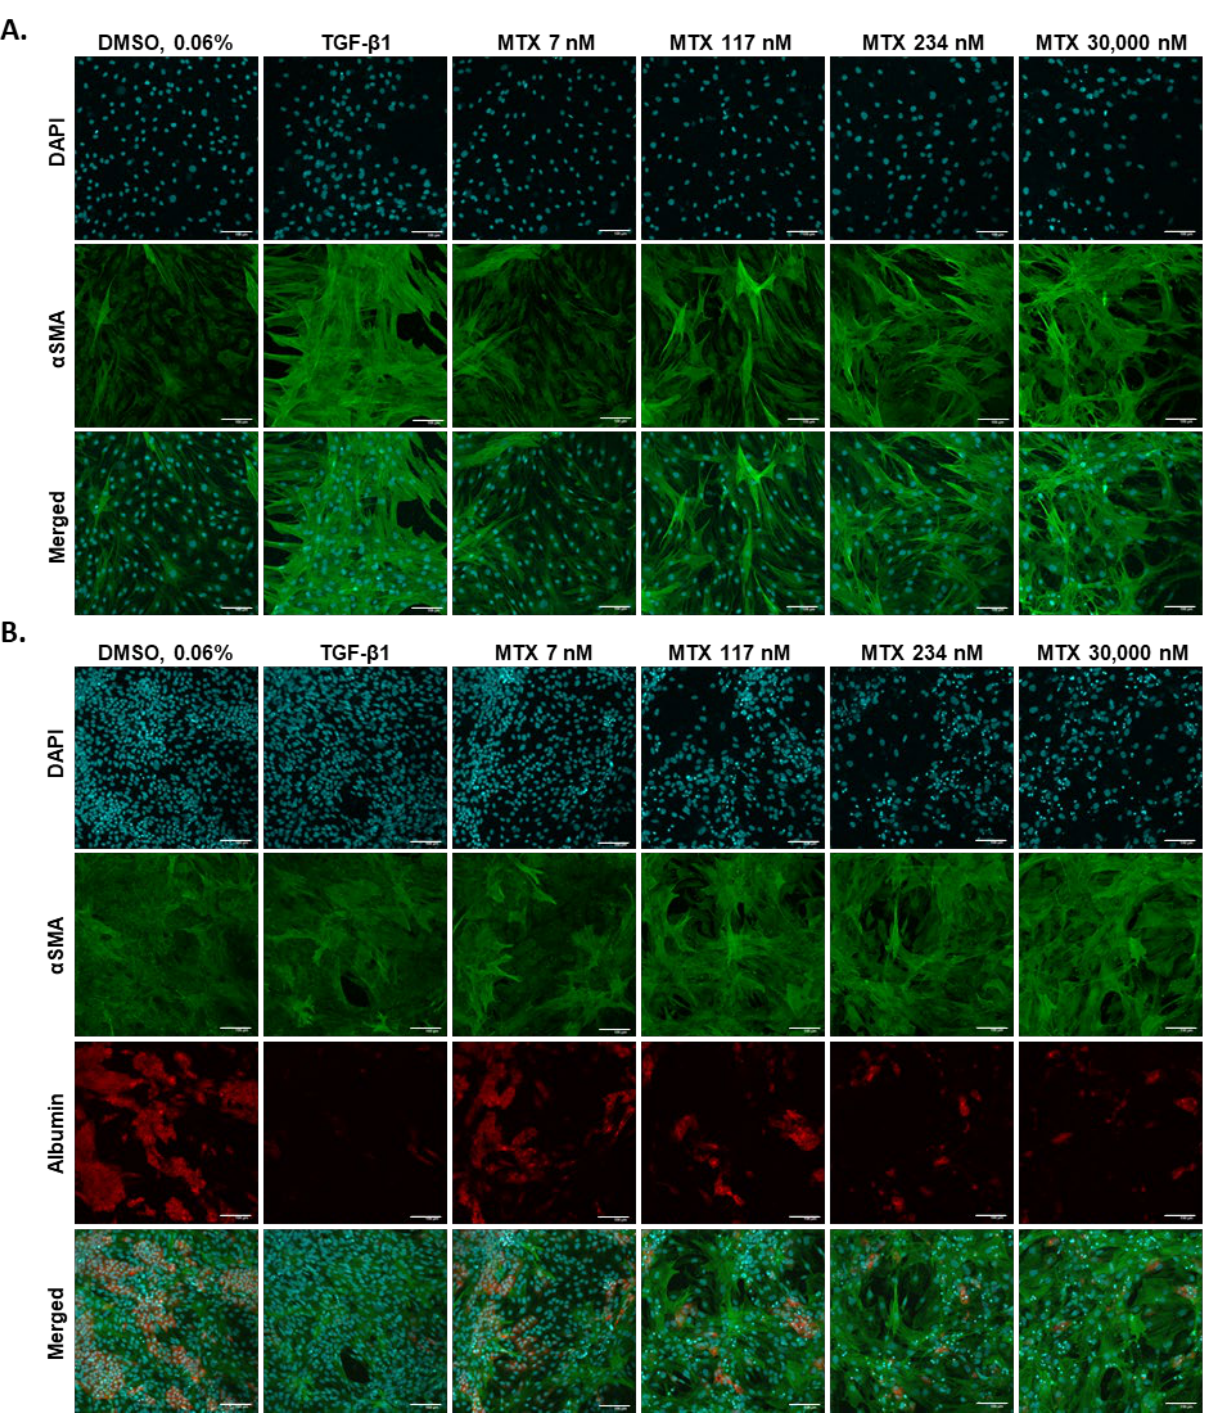
Figure 6. MTX triggers the activation of 2D hTERT-HSC in mono- and co-culture with HepaRG. Monocultures of 2D hTERT-HSC ( A ), or co-cultures with hTERT-HSC and HepaRG ( B ), were exposed to varying concentrations of MTX or the positive control TGF- β1 for 7 days. Cells were stained for stress marker αSMA (green), hepatocyte marker albumin (red) , and counterstained with DAPI (blue). Scale bar representing 100 µm.